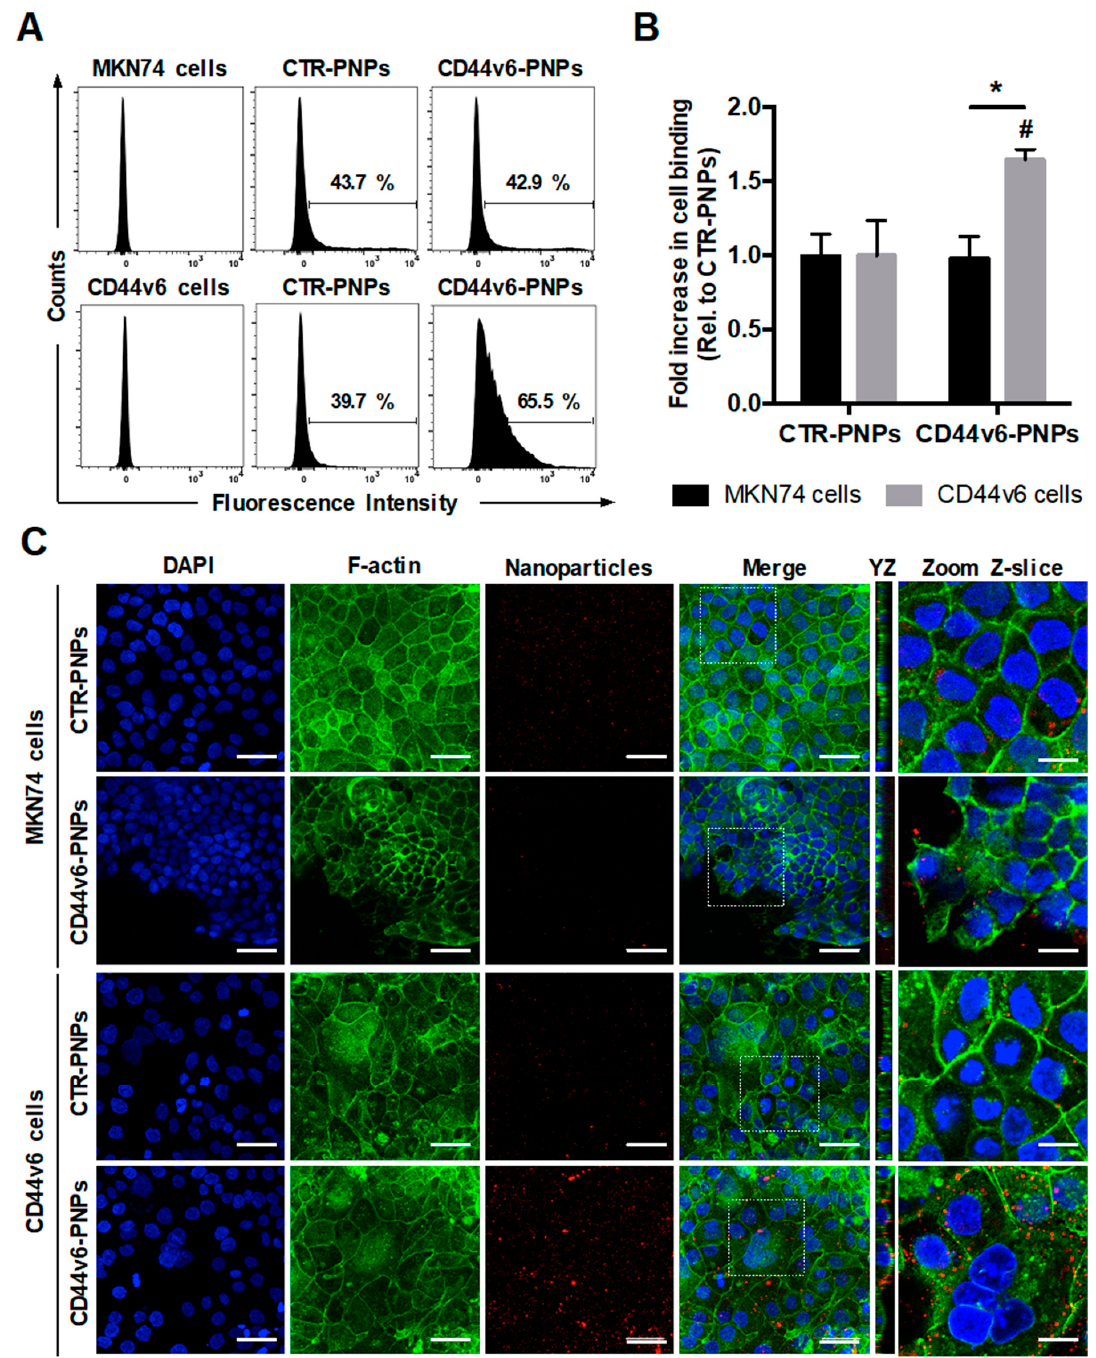
Figure 4. CD44v6 half-antibody conjugated PNPs selectively bind to CD44v6-expressing GC cells. Flow cytometry analysis showing ( A ) the percentage of MKN74 and CD44v6 cells binding to CTR-PNPs and CD44v6-PNPs and ( B ) the mean fold increase in cell binding over CTR-PNPs conditions after 90 min of incubation at 4 °C. A minimum of 10,000 events were evaluated for each measurement. * p < 0.05 from different cell lines within the same experimental condition and # p < 0.05 between experimental conditions for a given cell line. ( C ) Immunofluorescence images of MKN74 and CD44v6 cells incu- bated with 25 μ g/mL of CTR-PNPs and CD44v6-PNPs at 37 °C for 90 min. Scale bars = 50 μ m. The two rightmost panels correspond to YZ panels and a higher magnification of a single Z-slice confocal image acquired for each experimental condition. Scale bars = 20 μ m. Nuclei (DAPI), F-actin and PNPs are stained in blue, green and red, respectively. DAPI = 4 ′ ,6-diamidino-2-phenylindole.